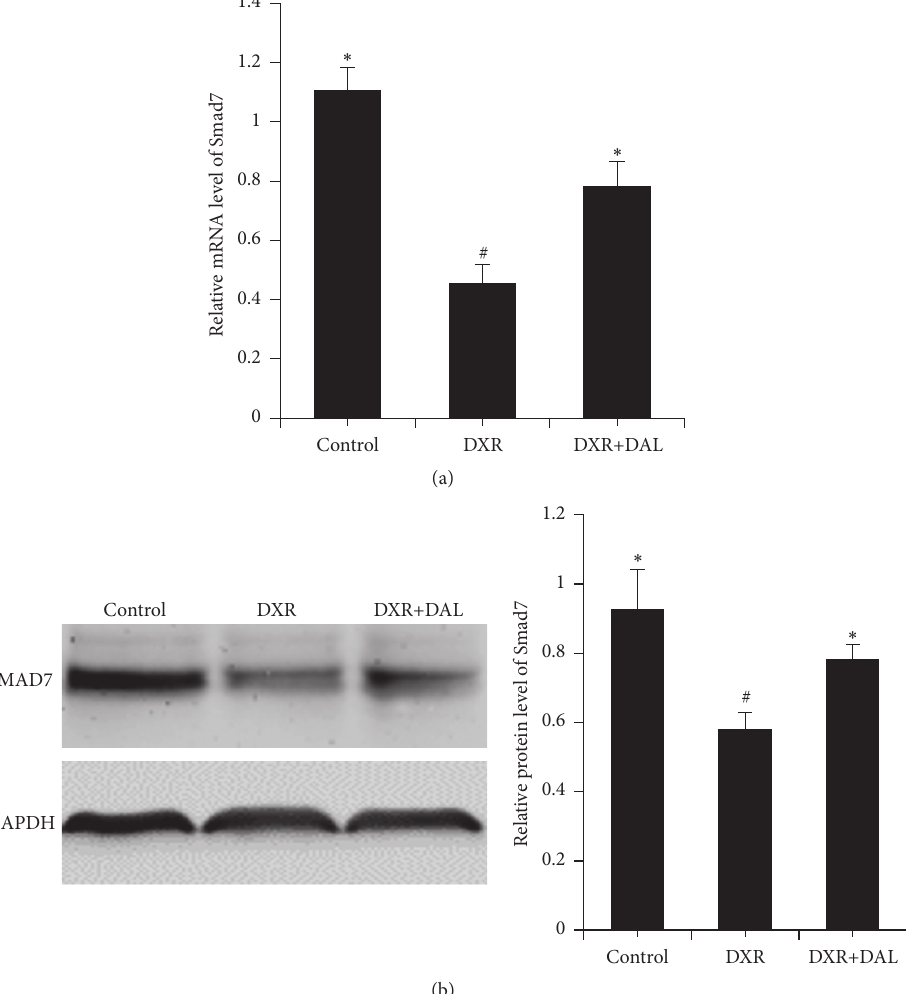
Figure 5: The expression of Smad7, an inhibitor of the TGF- 𝛽 signaling pathway, in kidney tissue 5 weeks after DXR injection in different groups of mice as indicated. (a) DAL increases the gene expression of Smad7; (b) DAL increases the protein expression of Smad7. The control and DAL treatment groups are compared with the DXR group. Values are statistically significant at ∗ 𝑝 < 0.05 ; the DXR group is compared with the control group. Values are statistically significant at # 𝑝 < 0.05